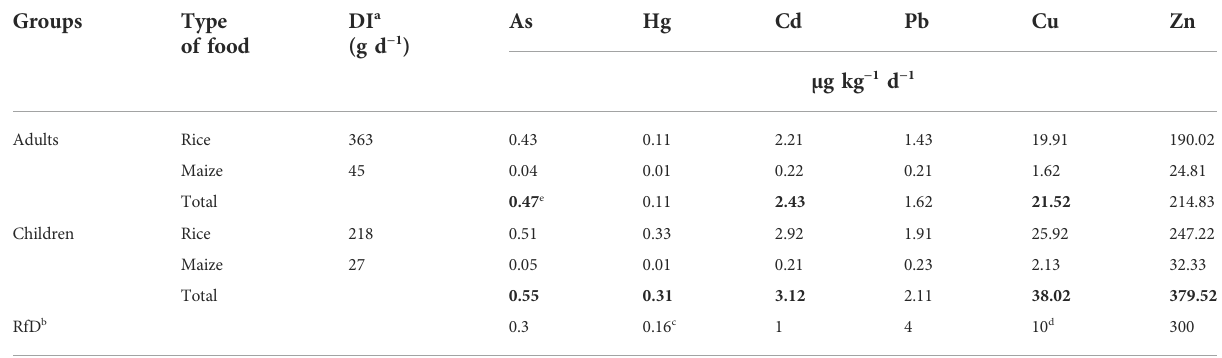
TABLE3Estimateddailyintake(EDI)ofmetalsbyconsumption ofriceandmaizeattheinvestigationarea(theEDIvaluesbasedonthebodyweightof 65 and 30kg for the adults and children, respectively). Groups